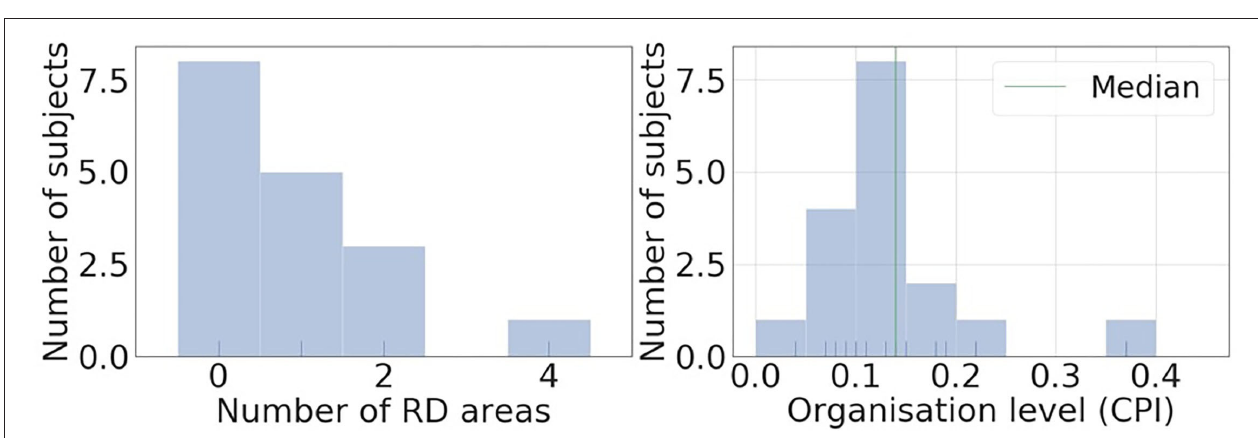
FIGURE 4 | Histograms of RD positive areas and causal pairing index (CPI) of the 17 subjects of clinical AF ECG/EGM dataset. Most of the subjects have less than 2 RD positive areas, and the median CPI of all subjects is 0.14.